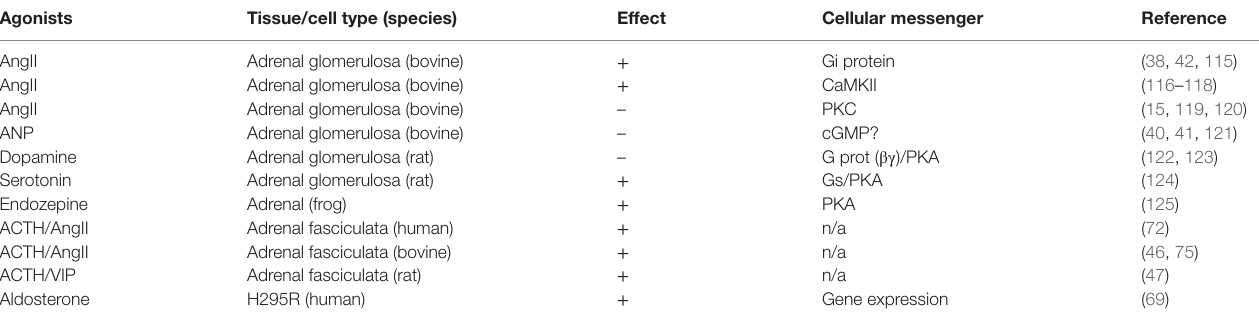
TABLe 5 | T-type calcium channel modulation by hormones in adrenal cortex.